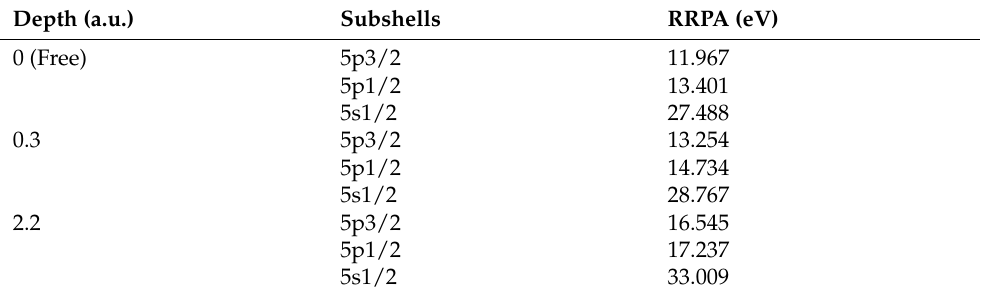
Table 3. The 5p and the 5s thresholds of free and confined Xe. Depth